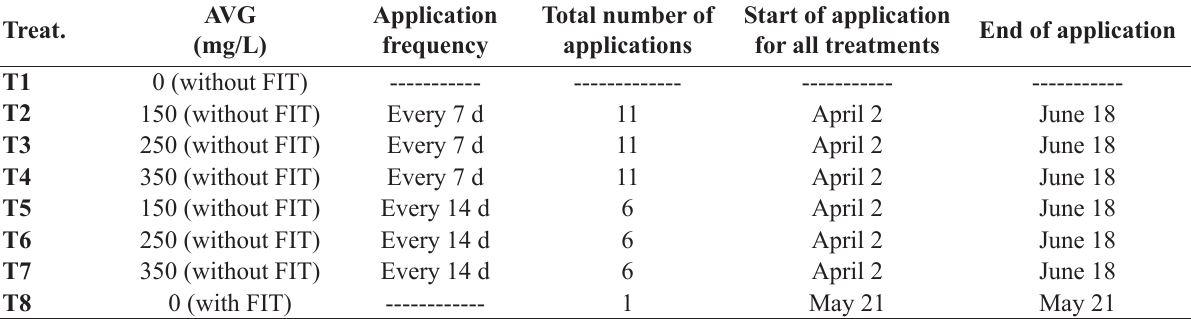
Table 1. Treatments, doses, application frequency, and date of Aviglycine applications on pineapple cv. ‘MD2’.